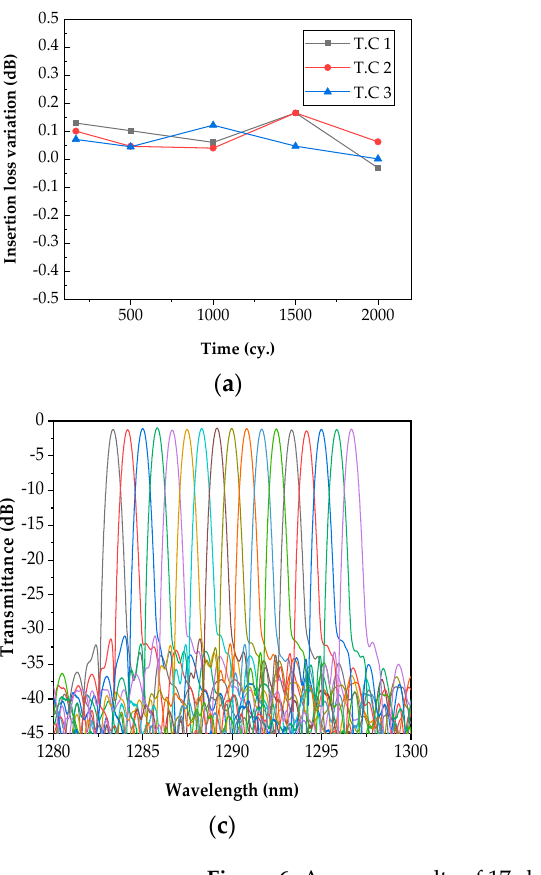
8 of 15 Figure 5. Temperature dependence of 17-channel AAWG module: ( a ) Spectrum of 17-channel AAWG module; ( b ) Temperature dependence of C.W.; ( c ) IL deviation of the temperature depend- ence for each of the three modules; ( d ) C.W. shift of the temperature dependence for each of the three modules. 4. Reliability Test Results for Internal and External Environmental Application Reliability Tests Result The reliability test of the 17-channel (150 GHz-spacing) AWG modules was con- ducted by referring to international testing standards [20,21] for passive optical compo- nents, and compared to the test on the previously developed product (50 GHz-spacing, 96 ch, AWG). Additionally, a harsher test condition was applied by adding an impact test and increasing the test cycle. The reliability test results were analyzed as shown in Table 2. The wavelength band was 1280~1300 nm, and the channel spacing was around 0.83 nm. To verify the reliability of the AAWG module, three samples for each test item were tested. To compare the sample’s performance, IL before and after the test, IL deviation, and C.W. were measured. As presented in the results of Table 2, according to the conditions of the reliability test, the measured maximum IL deviation was within the maximum ±0.40 dB, which sat- isfied the requirements of 0.5 dB or 10% by the above specifications. The average IL is an average of 1~17 channels in three samples, which were individually tested. It showed a range within the maximum of − 2.20 dB, which was smaller than the reference value of 4.6 dB in international testing standards [21]. Among the six items in the reliability test, the